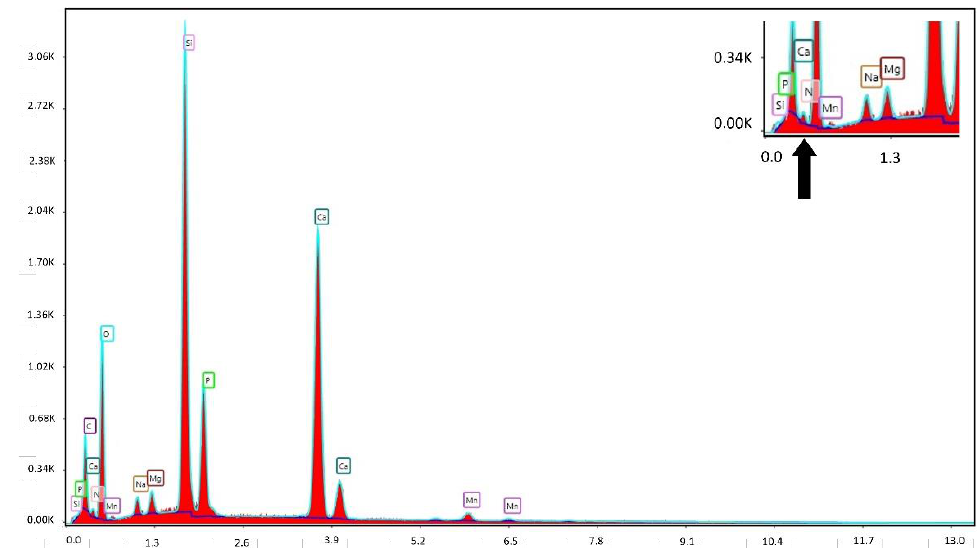
Figure 8. Elemental analysis of the BMP-MnGC functionalized surface by SEM-EDX. The region of interest is magnified in the upper right corner, and the peak related to nitrogen is indicated with an arrow.